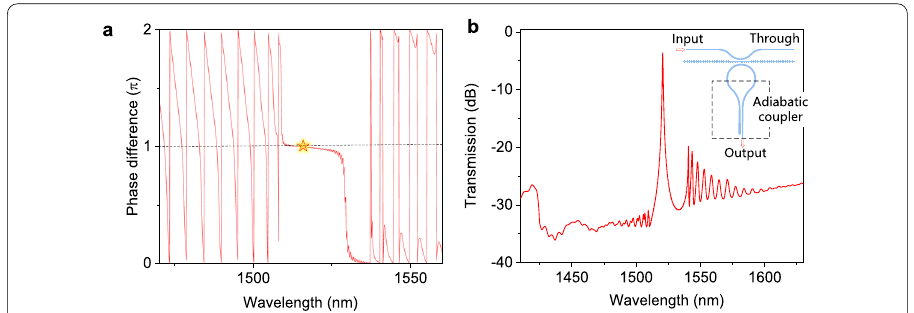
Fig. 7 Simulations of the design with the improved drop efficiency. a Simulated phase difference of the drop ports of the proposed ADF. The yellow star shows the resonance wavelength position. b Simulated transmission spectra of the improved device combining the 2 2 adiabatic splitter and the proposed ADF at × the output port (Drop port). The insert shows the schematic of the improved device